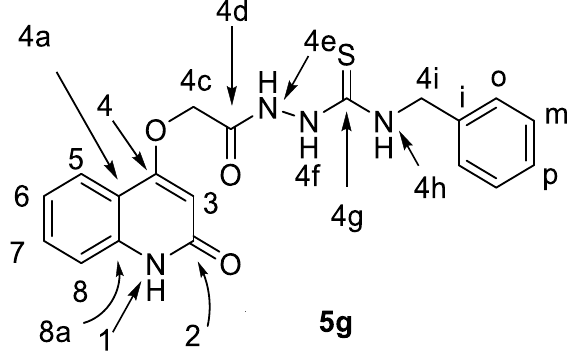
Figure 2. Structure of compound 5g .